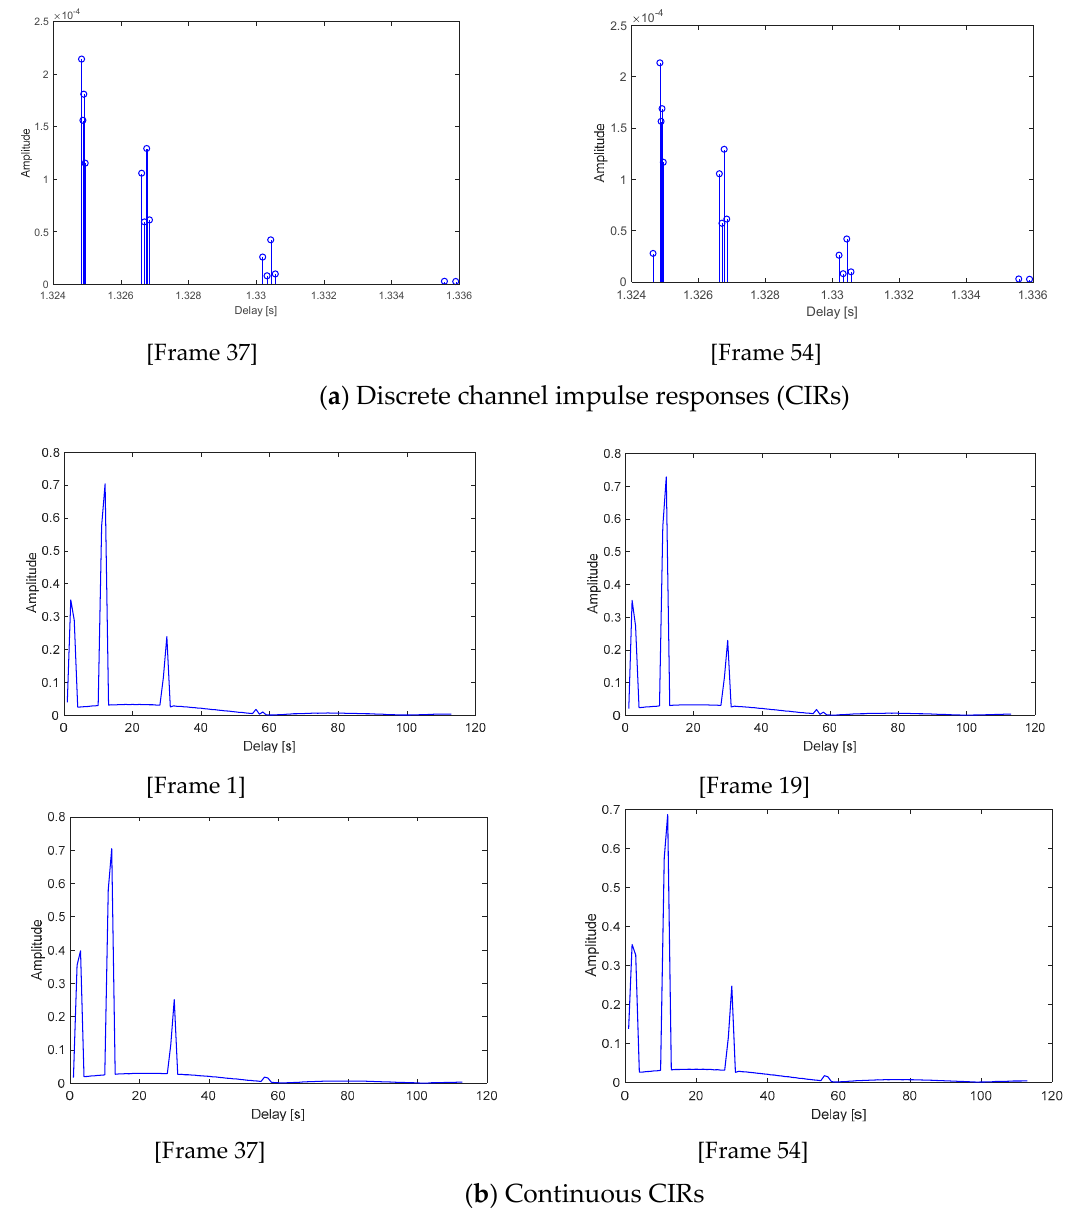
Figure 2. Discrete and continuous CIRs for different frames: ( a ) discrete CIRs; ( b ) continuous CIRs.